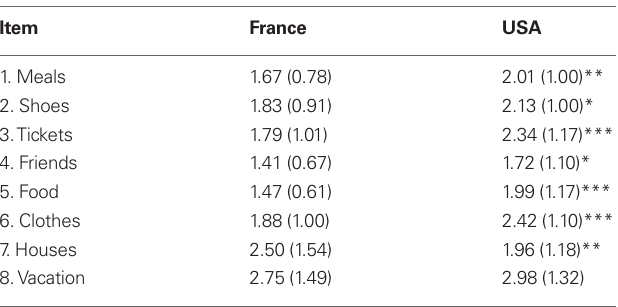
Table 5 | French and American scores on quality versus quantity [mean